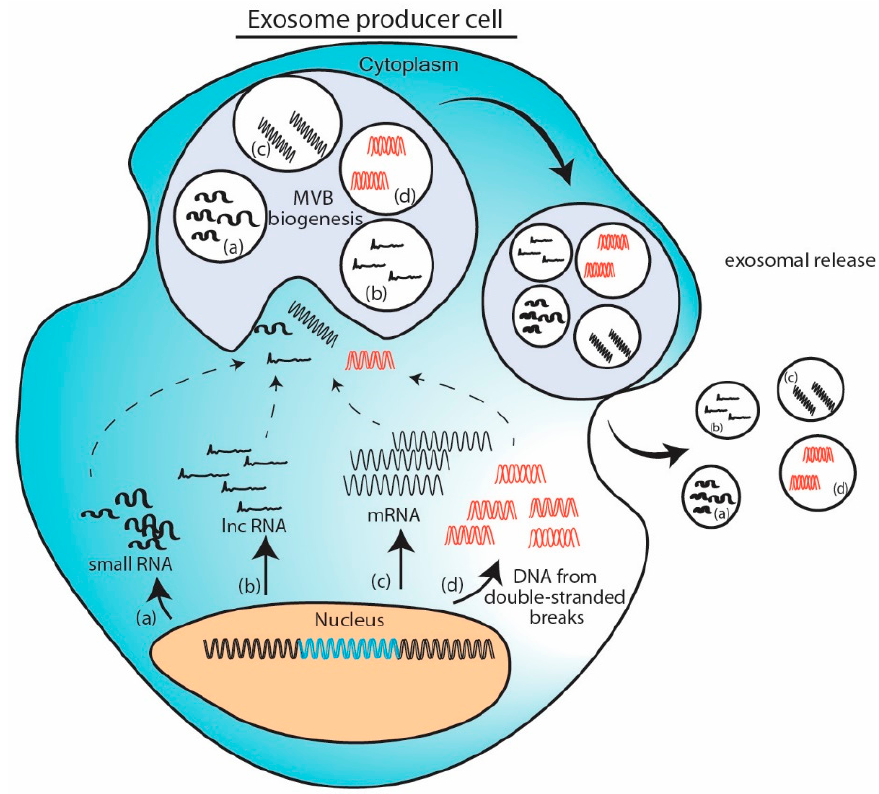
Figure 1. Cellular abundance induced packaging model. Excess nucleic acids in cells like ( a ) small RNA, ( b ) long non-coding RNAs (lncRNA), ( c ) messenger RNA (mRNA) or ( d ) DNA fragments are loaded into exosomes while formation of multivesicular bodies and are exported. Exosomes thus obtained contains overexpressed nucleic acid amongst other cargo.